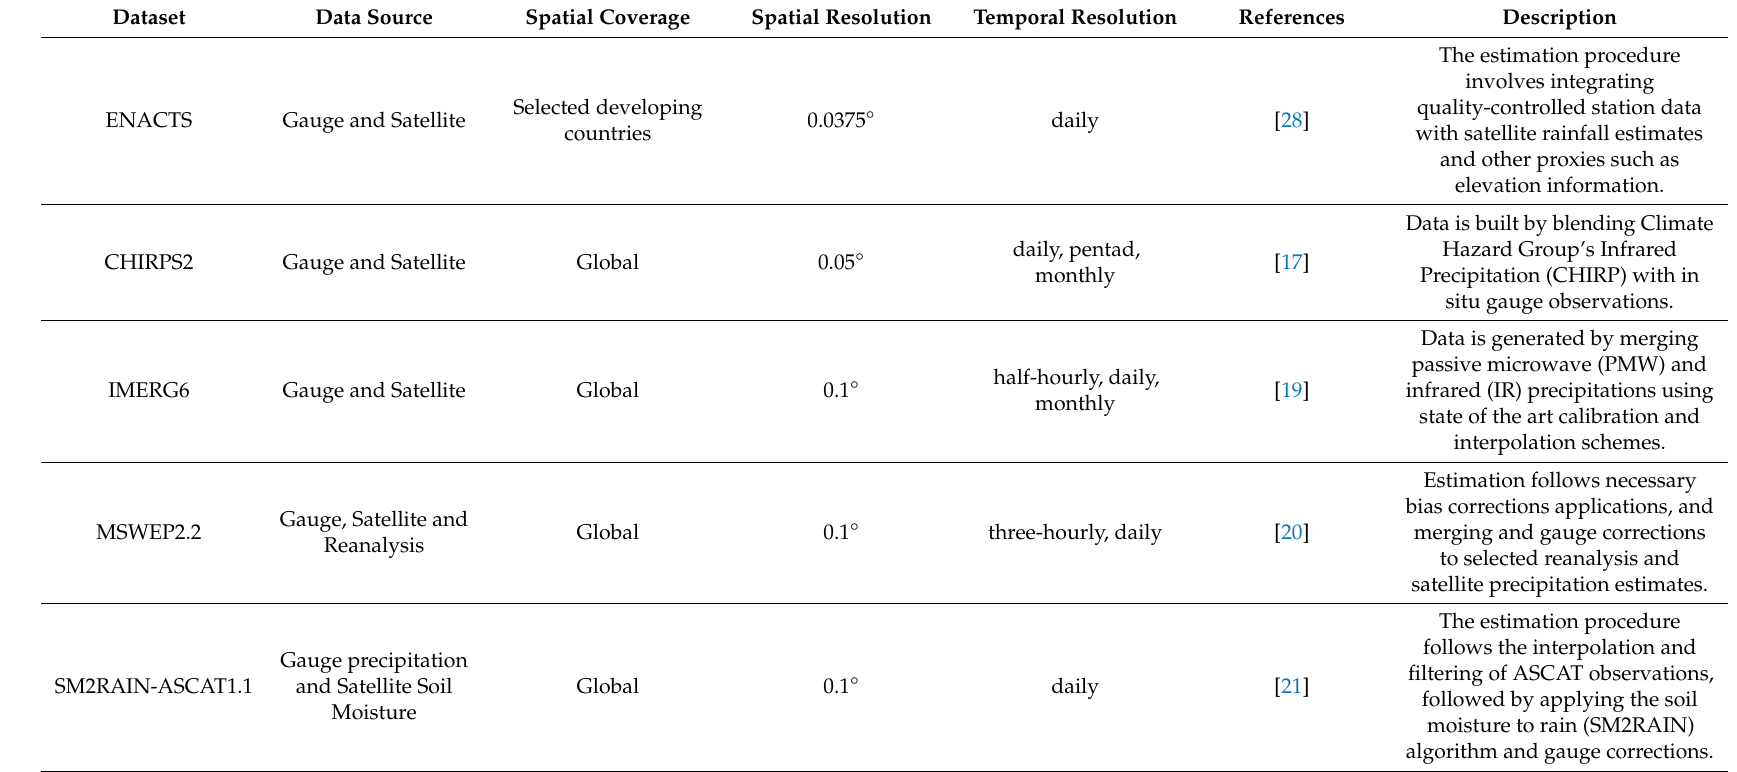
Table 1. Overview of precipitation datasets used in this